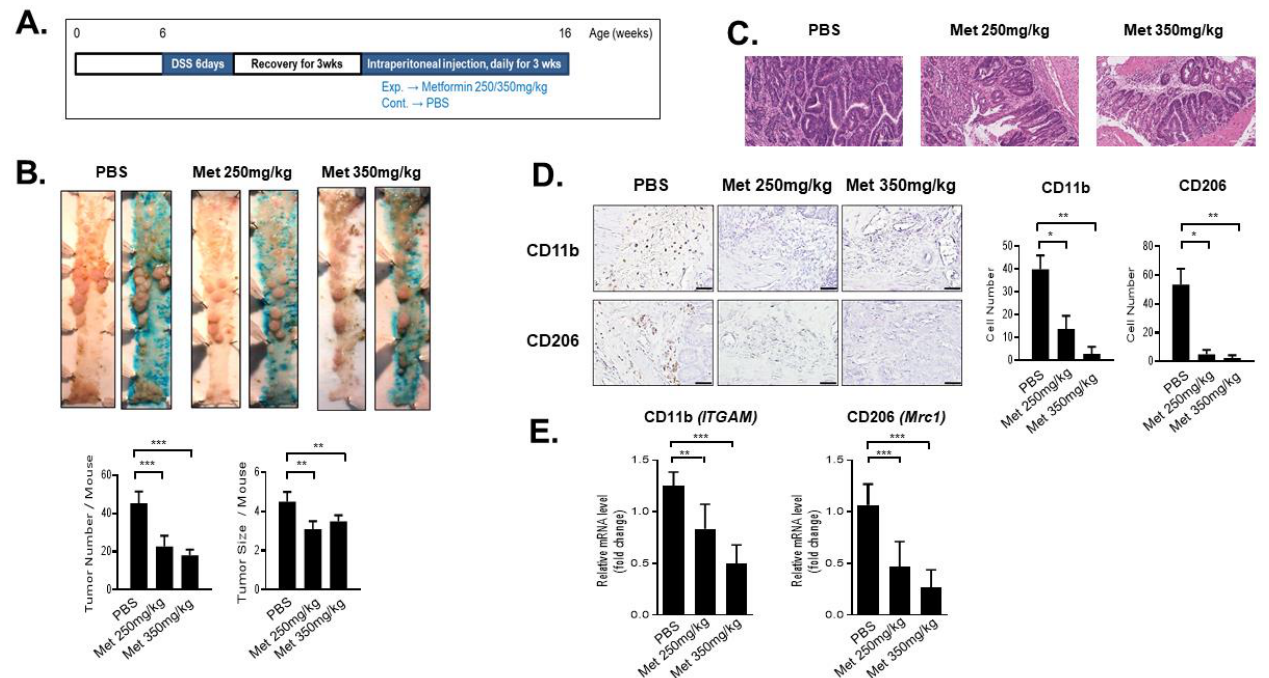
Figure 3. Effect of metformin on tumors of the mouse colon cancer model and immunohistochemistry analysis of MDSCs and M1/M2 macrophages. ( A ) In vivo tumorigenesis model experimental schedule, using Apc Min/+ treated with 3% DSS, and metformin treatment schedule. ( B ) After spraying methylene blue, the number and size of polyps in the colon were measured. Data are expressed as the means ± standard errors; ** p < 0.005, *** p < 0.001 (n = 3 per group). ( C ) Representative H&E staining of the rectum of mice (scale bar = 50 μm). ( D ) Immunohistochemistry (IHC) of the colon sections was performed on paraffin-embedded sections using MDSC (CD11b) and M2 macrophage (CD206) markers (scale bar = 50 μm). CD11b - and CD206-stained cells were counted in ten different fields under 200× magnification. Data are expressed as the means ± standard errors; * p < 0.05, ** p < 0.005 (n = 3 per group). ( E ) Mice colon tissues were homogenized and examined by real-time qPCR for CD11b (ITGAM) and CD206 (Mrc1), and normalized to β -actin expression. Data are expressed as the means ± standard errors of the three different experiments; ** p < 0.005, *** p < 0.001. n = 3 per group.